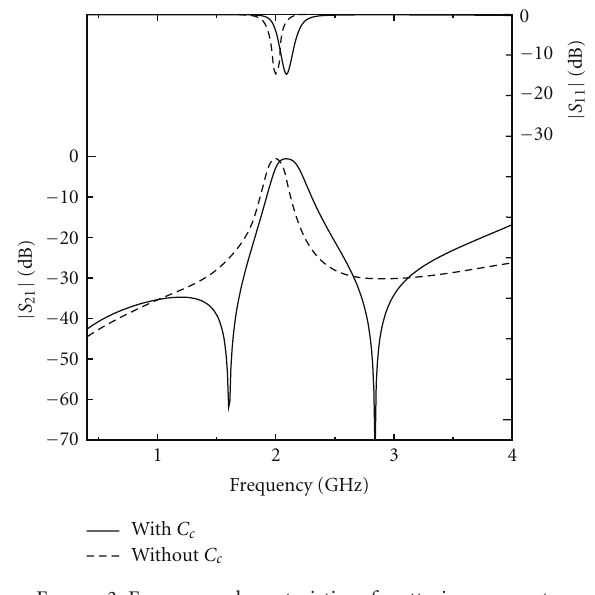
Figure 3: Frequency characteristics of scattering parameters.